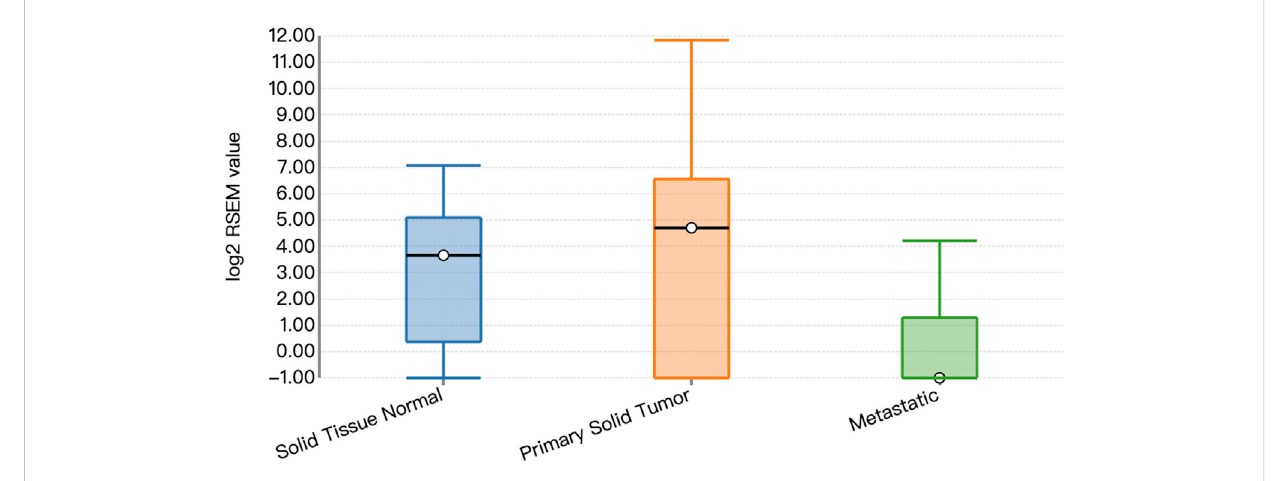
FIGURE 5 Expression of exon 3-skipped